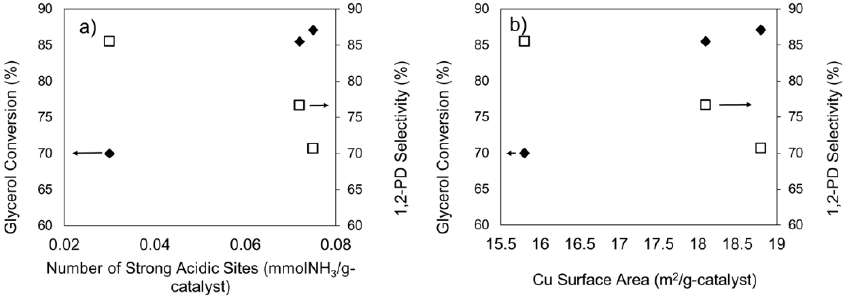
Figure 10. Effect of: ( a ) Number of strong acidic sites; ( b ) Cu surface area on glycerol conversion and 1,2-propanediol selectivity. Conditions: 220 °C, 1.5 MPa N 2 , 100 g feedstock mixture, 20 wt% glycerol, 32.2 wt% of water and 47.8 wt% methanol (water/methanol molar ratio = 1.2), 3 g catalyst, 500 RPM, 8 h.